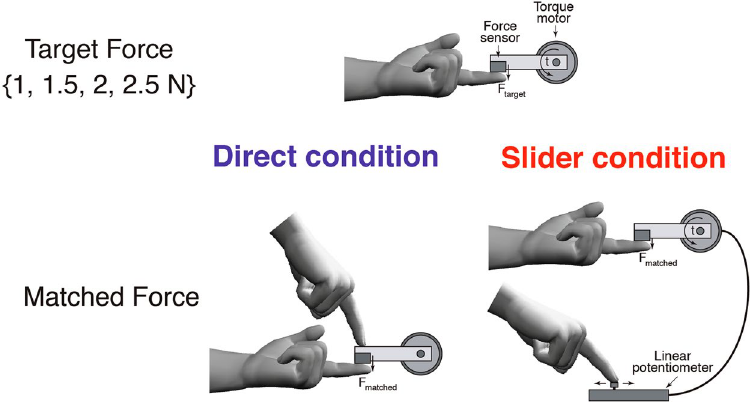
Figure 1. Force matching task illustration. Illustration of the force matching task. In each trial, a torque motor pseudorandomly applied one of four force levels (target force) through a lever to the participants’ left index finger. Participants were asked to match the force they had just sensed (matched force) either by pressing the lever with their right index finger (‘Direct’ condition); or by sliding a linear potentiometer which controlled the torque motor (‘Slider’